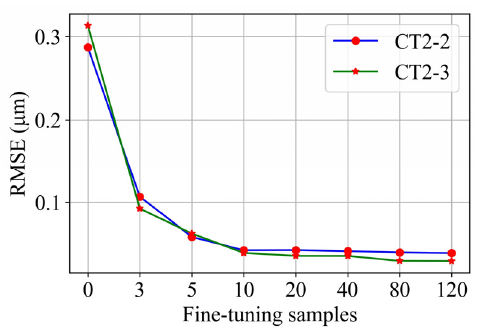
Figure 12. Effect of using different numbers of fine-tuning samples in the T1 task on prediction. (2) Effect of using different lengths of historical data ( k ) on prediction The resulting variations of RMSE with k ( k vs. RMSE curve) and training time with k ( k vs. training time curve) when transfer task T1 is considered and the number of fine-tuning samples is fixed to 10 are shown in Figure 13. The blue and orange lines are the k vs. RMSE curves of CT2-2 and CT2-3, respectively. The green line is the k vs. training time curve of each epoch in the training process. The RMSE is observed to distinctly decrease with the increase in k until k = 5. Beyond this, any further increase in k has an extremely slight effect on reducing the RMSE , causing RMSE to fluctuate; in addition, the training time rapidly rises with k . By considering the RMSE and training time, the selected k value is 5.